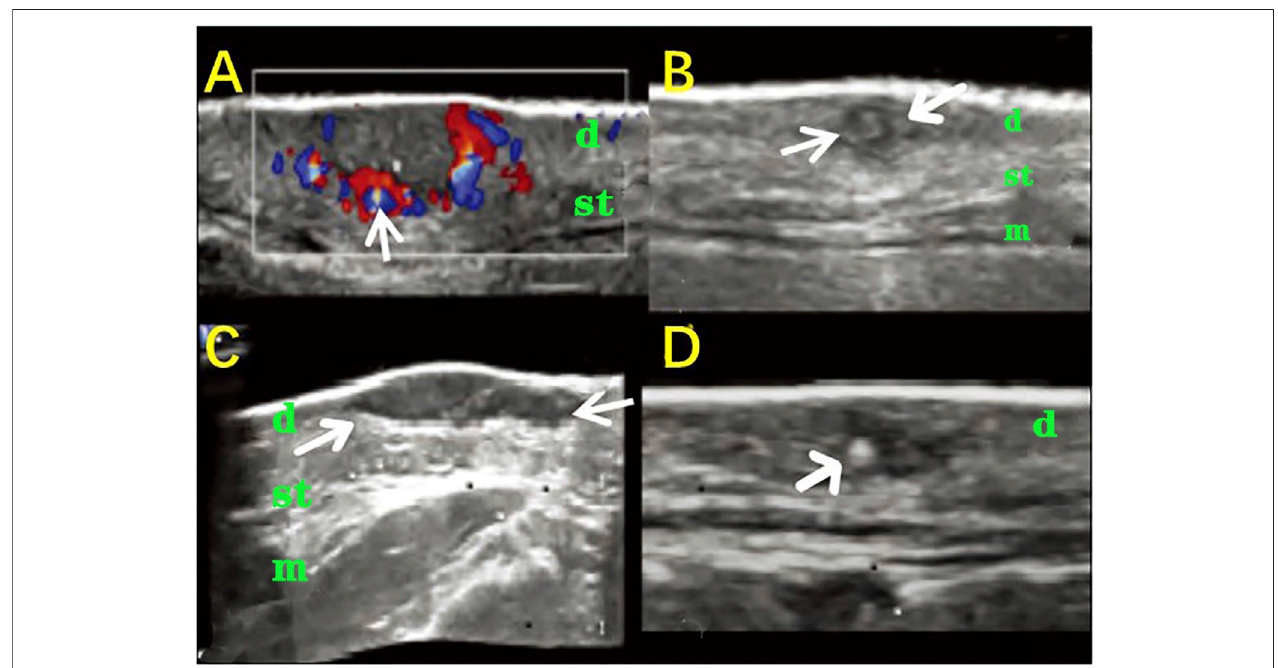
FIGURE5 | HFUS in identifying the different types ofacne. (A) Afalse cyst-type dermis and subcutaneous tissue withina low-echo nodule; thearrow indicates the rich blood fl ow around the nodule; (B) The hair follicle type between the two arrows shows a slightly tilted low echo across the dermis; (C) A fi stula type low-echo structure of the belt between the two arrows is located in the dermis and subcutaneous tissue layer; (D) The calci fi cation arrow shows the dot calci fi cation stove in the dermis. (d: dermis, st: subcutaneous tissue, m: face muscle).